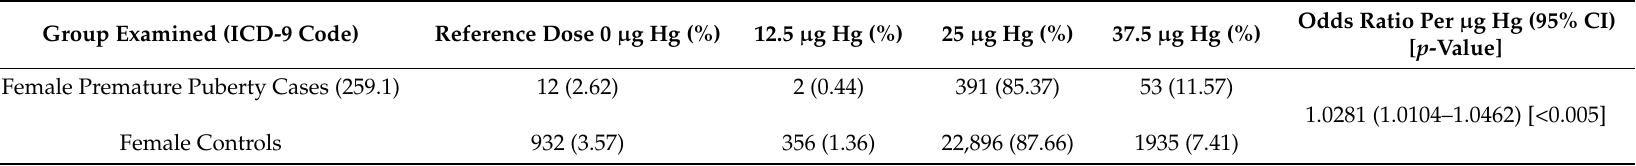
Table 4. This table summarizes the logistic-regression results of the effect of exposure to organic Hg in Thimerosal-preserved hepatitis B vaccines, used within the first six months after birth, for female cases with a premature puberty diagnosis compared to the female controls 1